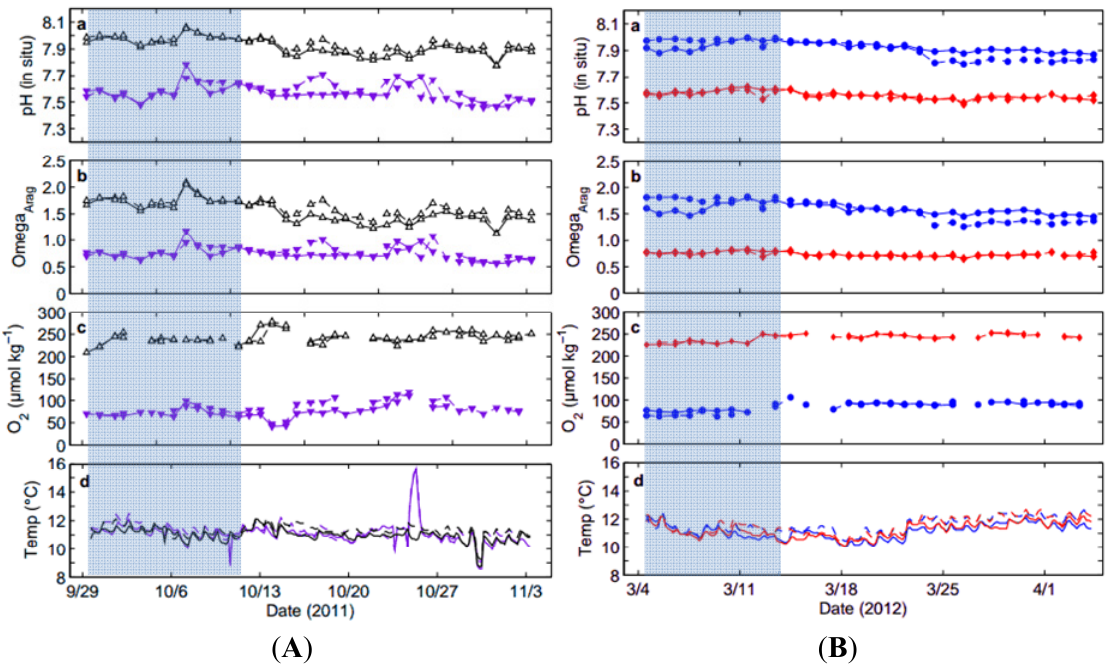
( c ) [O ] (µmol·kg − 1 ) and ( d ) temperature (°C) of the seawater within each tank of 2 ( A ) Experiment 1 and ( B ) Experiment 2. Purple = Low pHOx; Black = High pHOx; ]; Red = Low pH. The graphic is modified from Bockmon et al. (2013) [67]. Blue = Low [O 2 Blue shading = the estimated period prior to statocyst development (prior to the formation of the